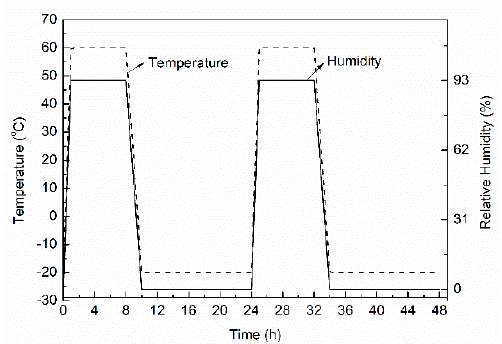
Figure 2. Schematic diagram of multi-field temperature–humidity cycling tests.